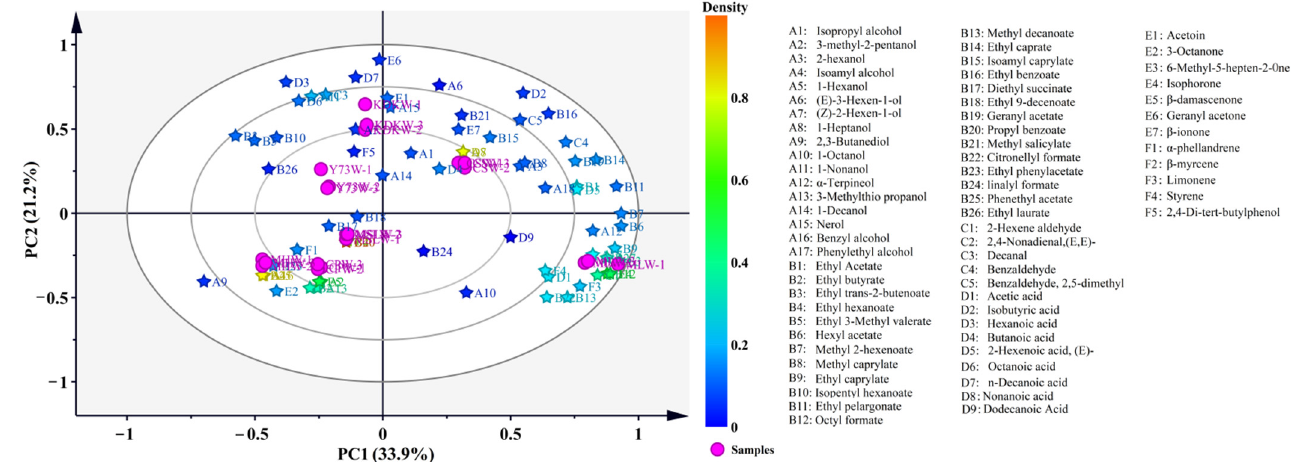
Figure 10. Biplot of PCA for volatile compounds of wines produced from seven different grape varieties. Samples’ full names, as follows: MSL (Marselan), Y73 (Yan 73), MH (Muscat Hamburg), KDK (Kadarka), ML (Merlot), CS (Cabernet Sauvignon) and CP (Crimpose). Furthermore, G represents “grape” and W represents “wine”. Here, − 1, − 2, and − 3 indicates, respectively, replicates 1, 2, 3.